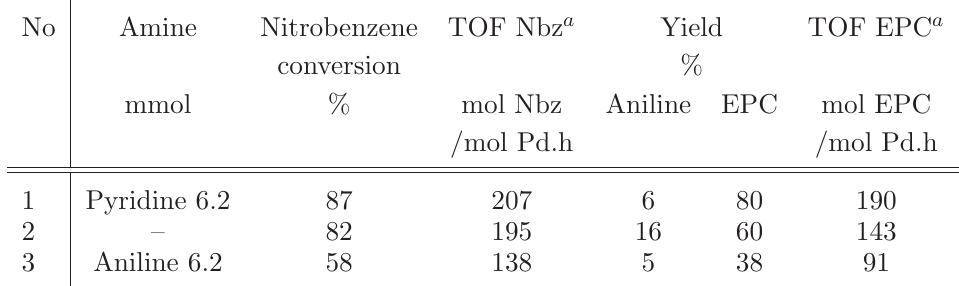
Table 4 The effect of the amount of amine on reductive